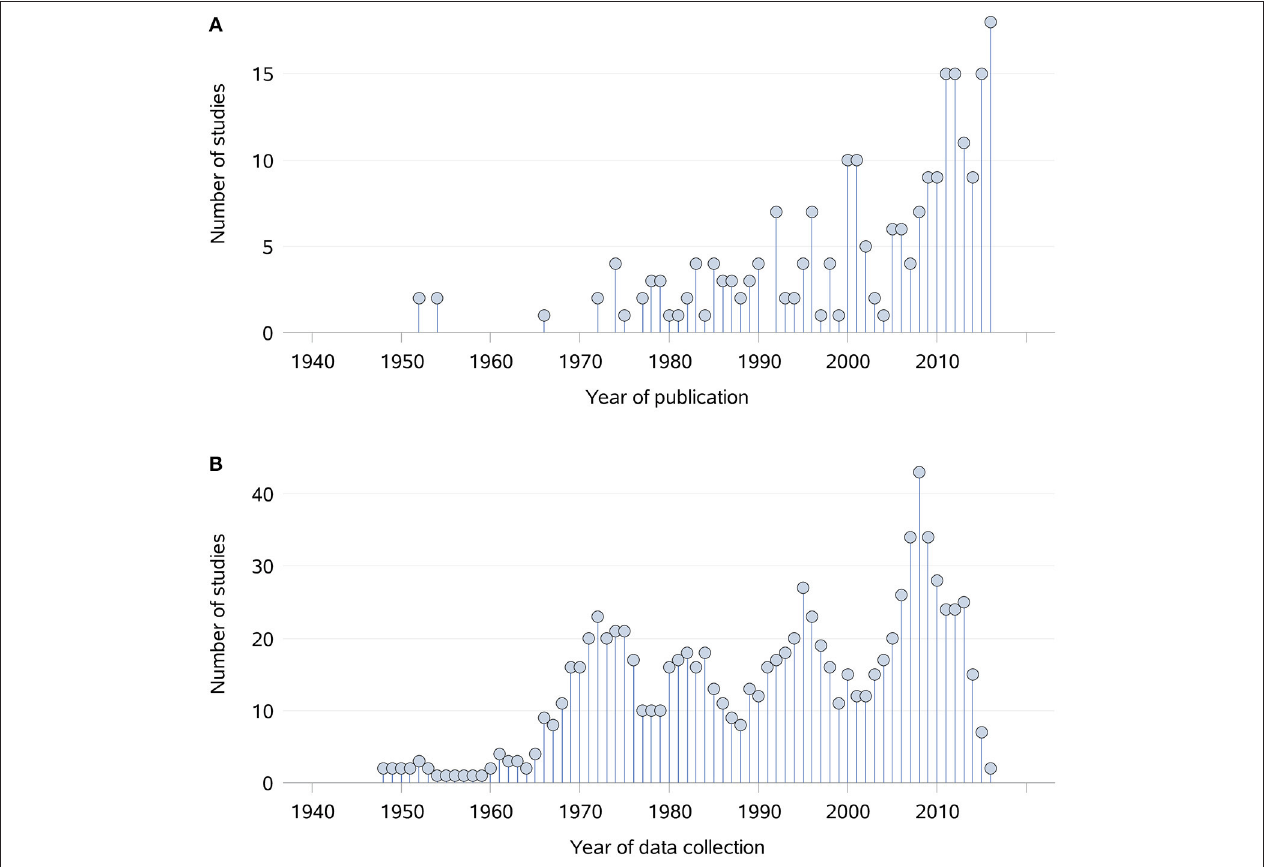
FIGURE 5 | Distribution of the 229 studies captured from a scoping review on the ecology and biology of dingoes, feral domestic dogs, and dingo-dog hybrids in Australia, by year of publication (A) and year of data collection (B) between 1940 and 2016. Prior to 1940, only one study published relevant data in 1862. During the period 1852–1862 and 1883–1930, the number of studies for which data of interest was collected during each year was equal to one. All other years between 1852 and 1940 did not contribute to the collection of data of